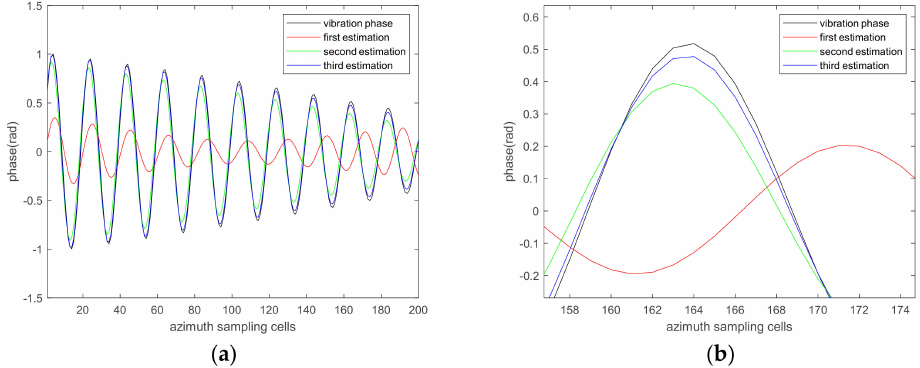
Figure 17. ( a ) Vibration phase and its estimated value under condition 4. ( b ) Partial enlargement of ( a ).